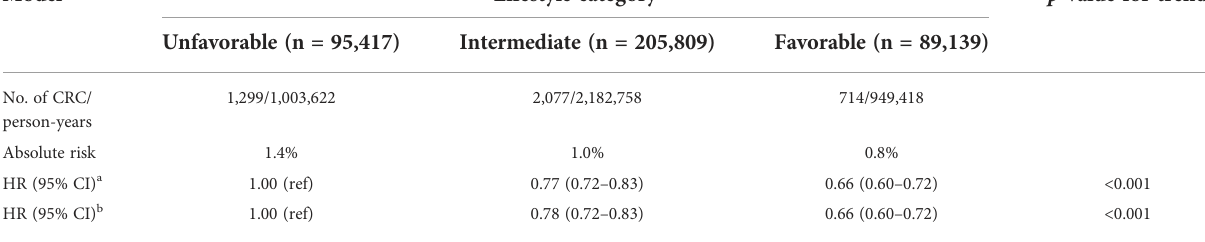
TABLE 2 Risk of CRC according to lifestyle category.